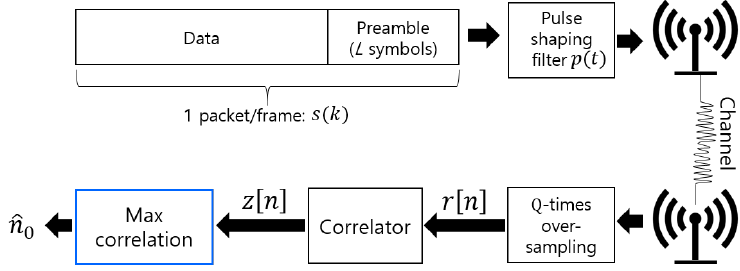
Figure 1. Overall block diagram of the conventional correlation-based frame synchronization.